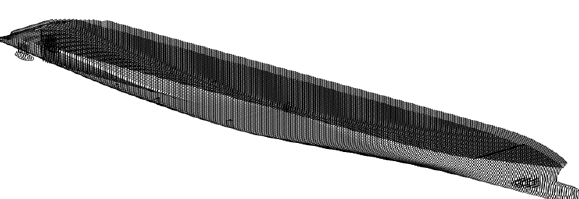
Figure 16. Hull geometry for cruise ship C1 used for stability calculations. Table 4. General particulars for cruise ship C1.